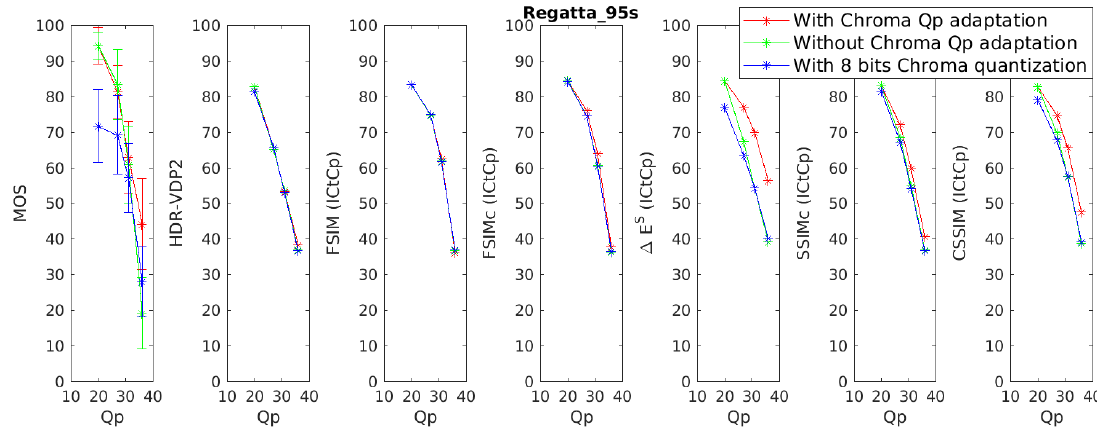
Figure A13. Subjective and objective scores for the image